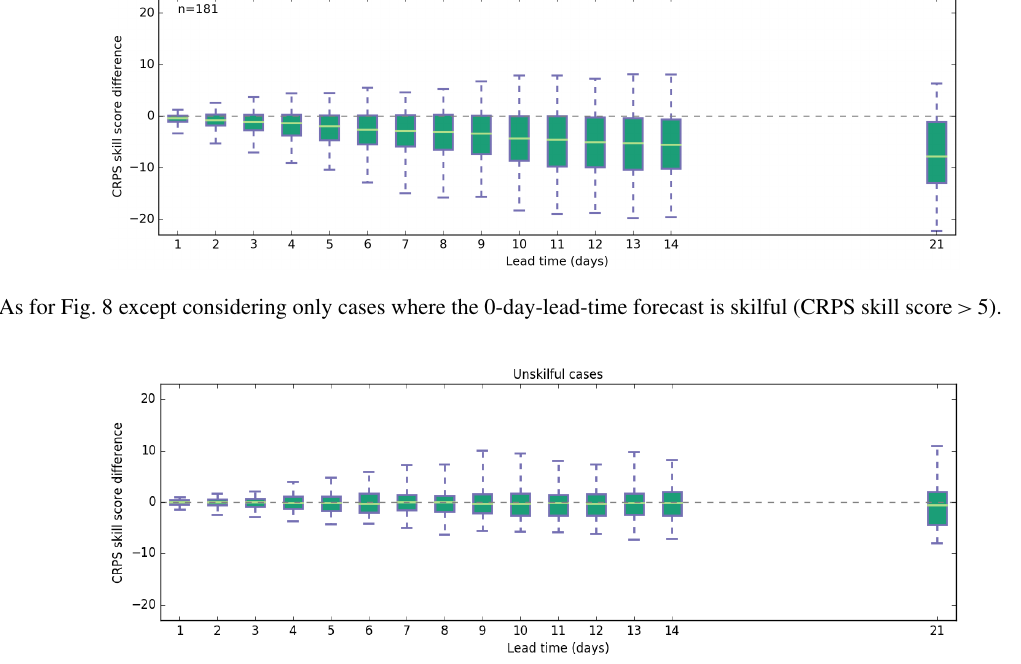
Figure 10. As for Fig. 8 except considering only cases where the 0-day-lead-time forecast is not skilful (CRPS skill score < = 5).